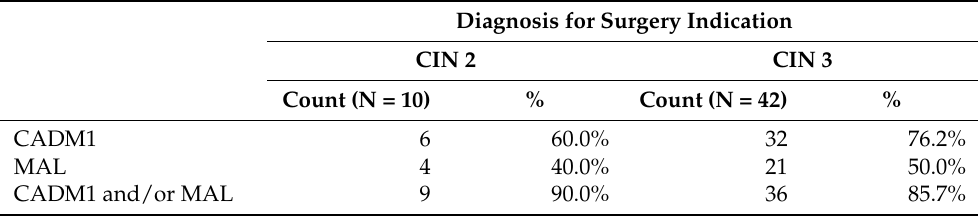
Table 1. CADM1, MAL, and CADM1 and/or MAL methylation status of smear samples from 52 cervical dysplasia patients in relation to the severity of dysplasia. Diagnosis for Surgery Indication CIN 2 CIN 3